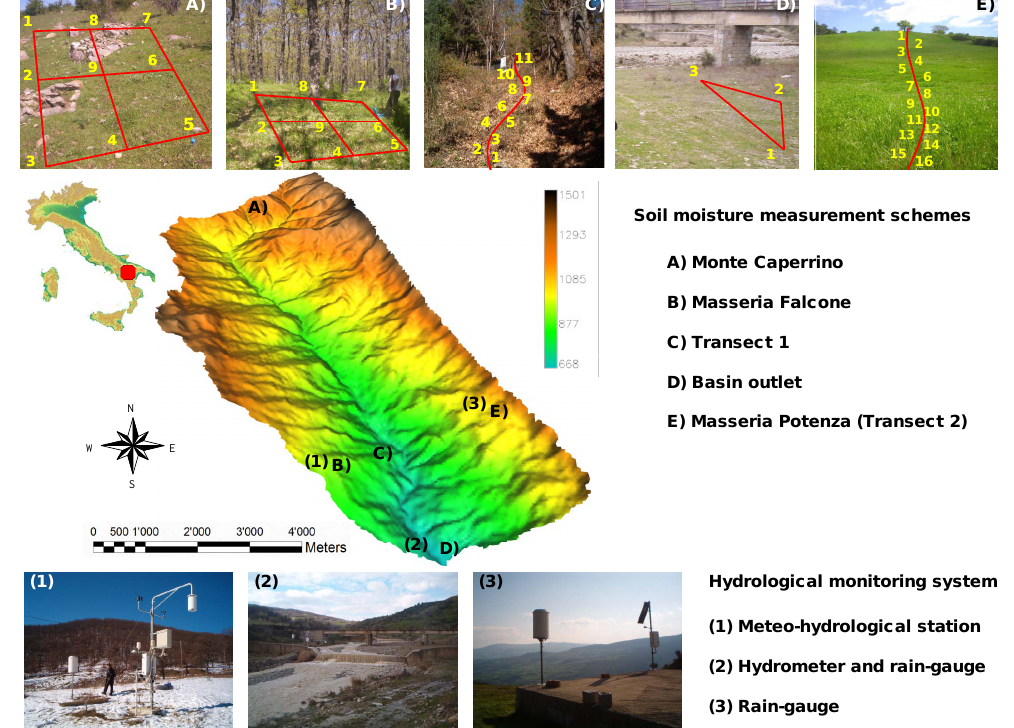
Fig. 1. Description of the experimental area of “Fiumarella of Corleto” with the identification of the three permanent hydrological stations devoted to the continuous monitoring of the basin. In the same page, one finds the SM measurements sites of this comparison with the definition of the sampling scheme adopted in each